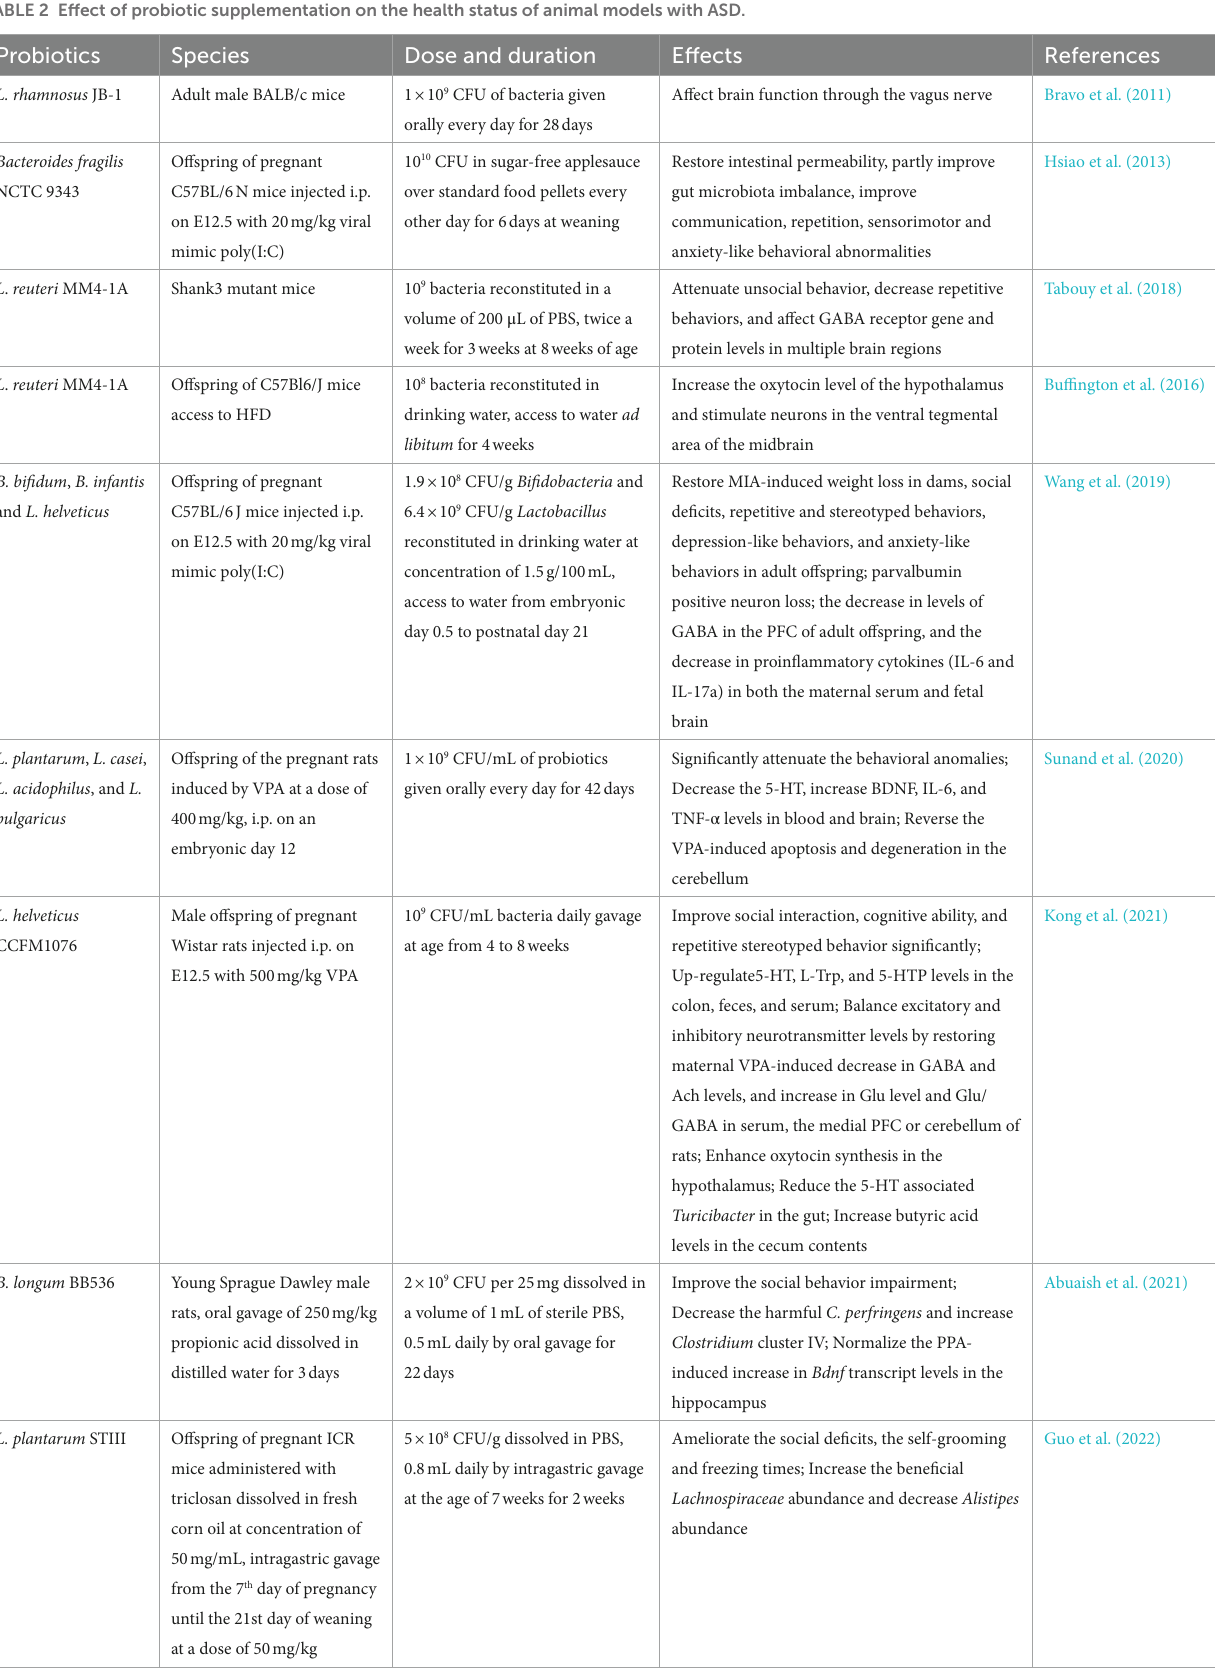
TABLE 2 Effect of probiotic supplementation on the health status of animal models with ASD.